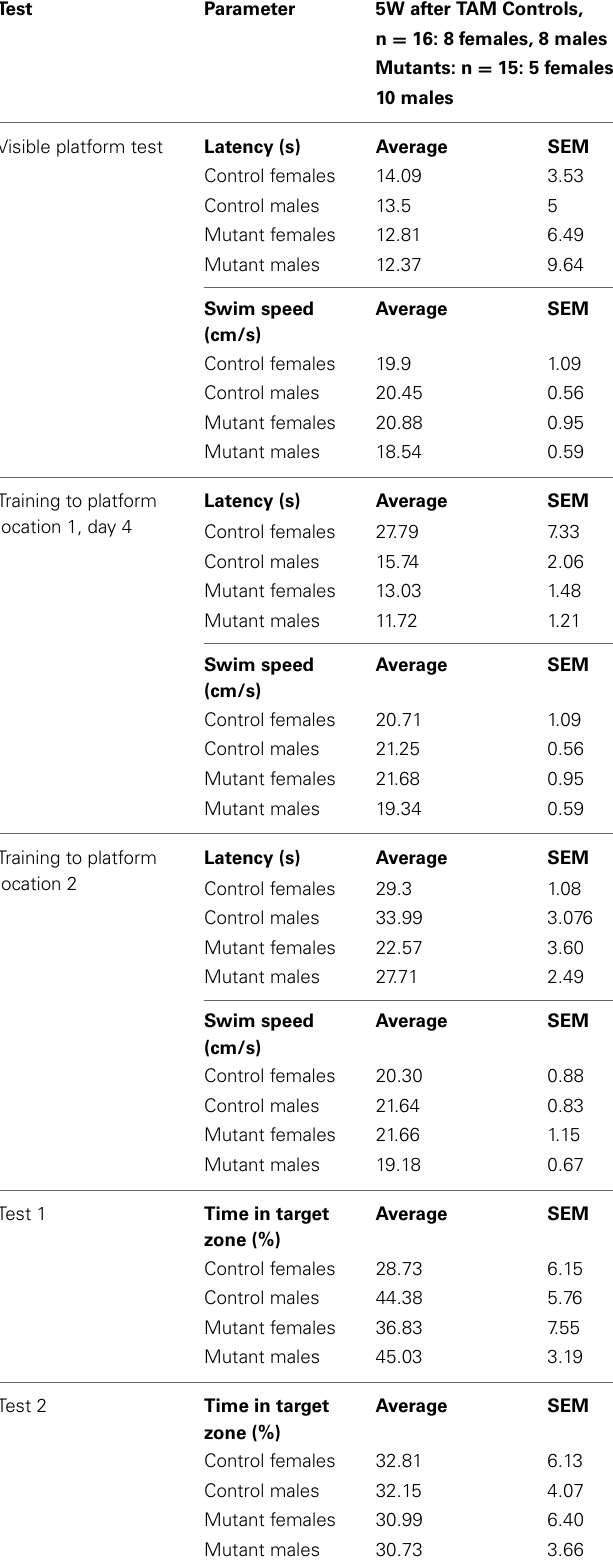
Table 2 | Analysis of gender differences in control and TIF-IA CaMKCreERT2 5 weeks after tamoxifen